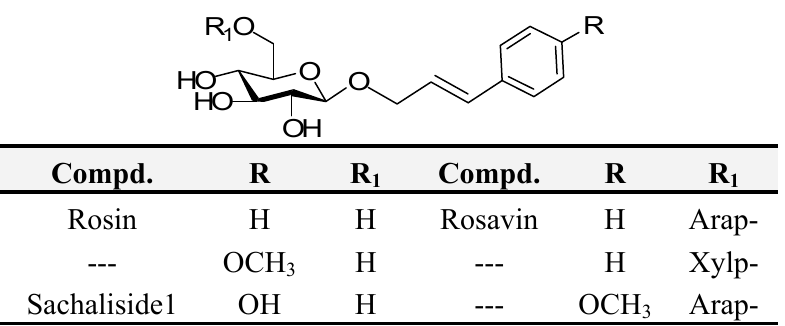
Figure 1. Phenylpropanoid glycosides Isolated from Rhodiola rosea